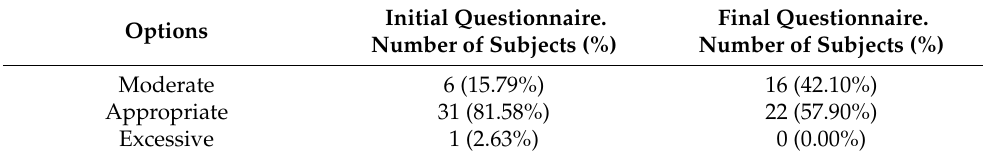
Table 6. Item 4: Time to be spent compared to the knowledge gained.